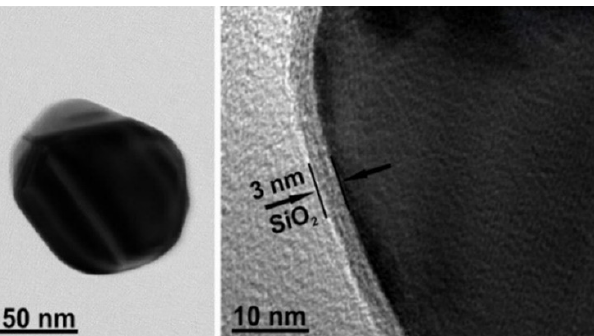
Figure 2. HR-TEM images of Ag@SiO 2 nanoparticles. Ag core and SiO 2 sizes were 85 ± 5 nm and 3 nm.